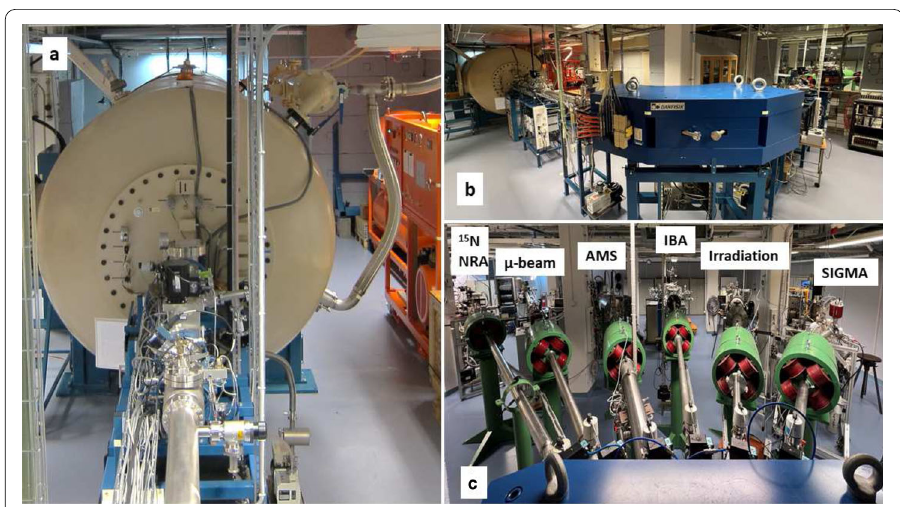
Figure 4 Tandem Laboratory at the Uppsala University: ( a ) the accelerator; ( b ) analysing magnet; ( c ) six beamlines with the description of their main